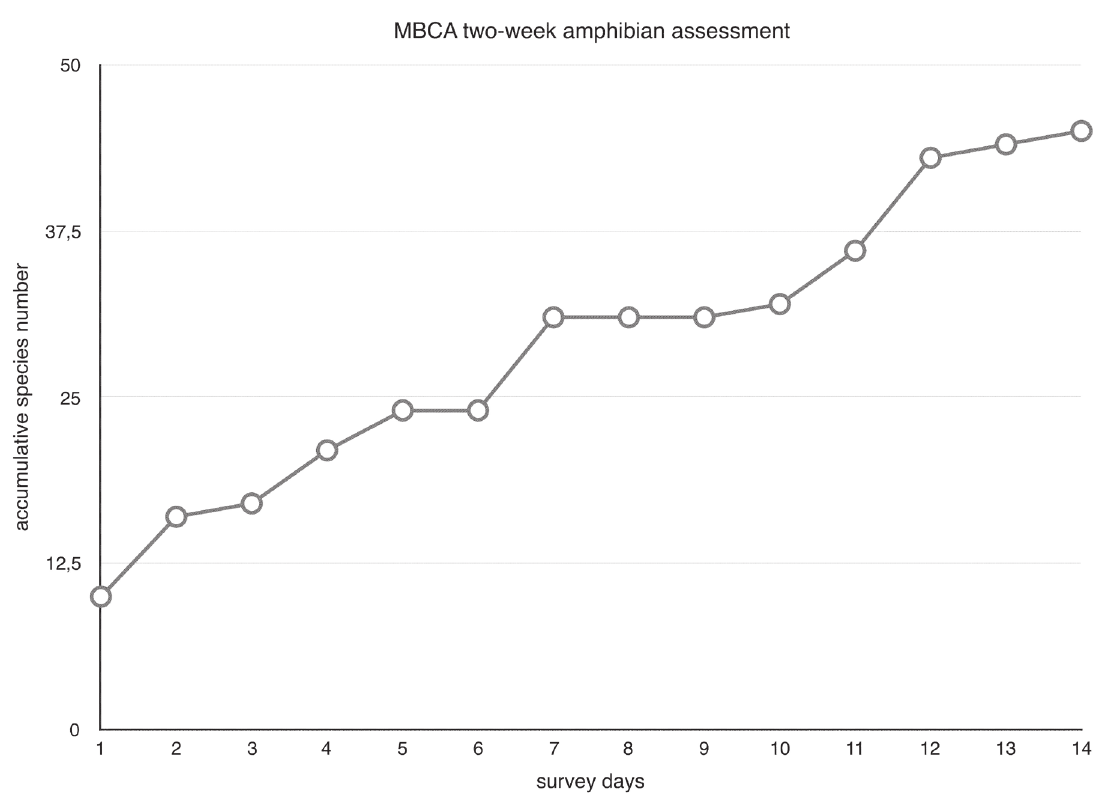
Figure 6. Accumulative species curve from species encounters at three sites within MBCA, 16 February 2017 to 2 March 2017.